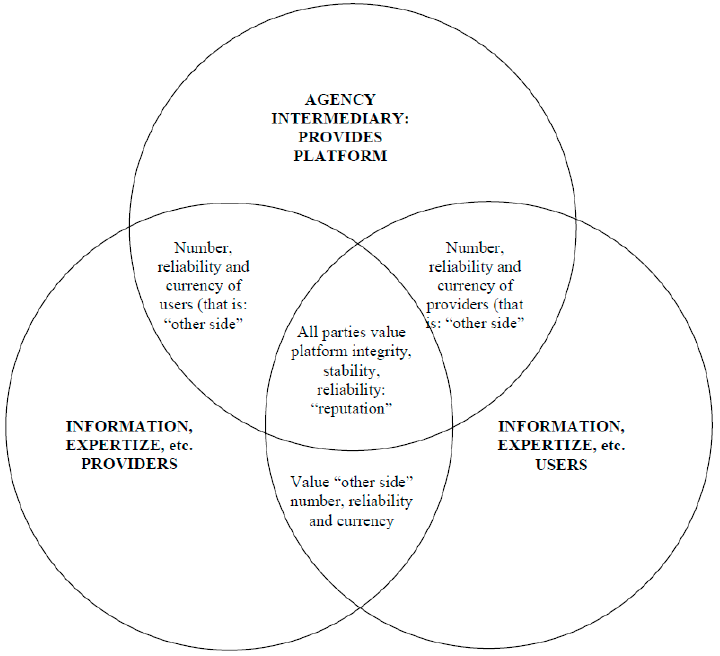
Figure 4. Illustrative Platform Value Creation Model/Metaphor and the Various Value Intercessions.